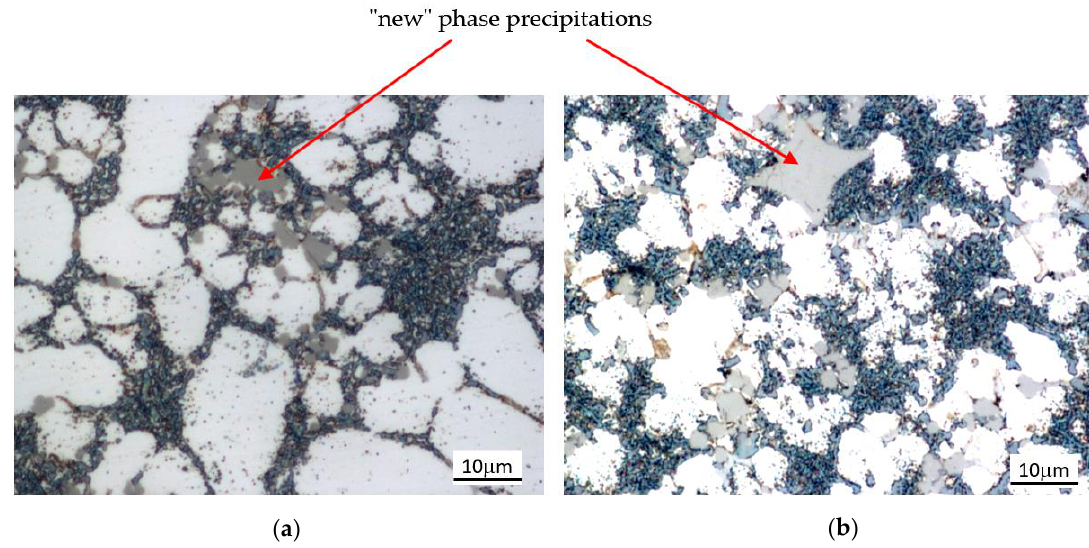
Figure 13. Microstructure of the HPDC Al-Si alloy with the addition of V and W in an amount of approximately ( a ) 0.2 wt %, ( b ) 0.3 wt %. The microstructure: ‘new’ intermetallic phase, α(Al), eutectic mixture.